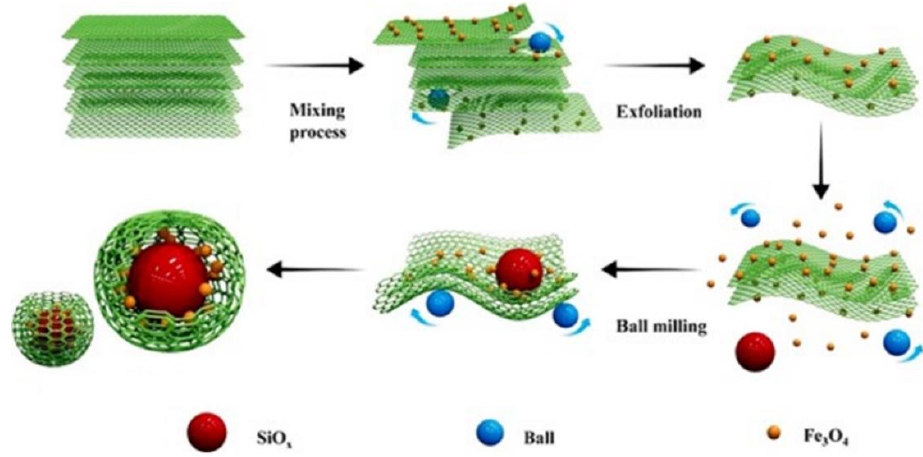
Figure 7. Production scheme of Fe 3 O 4 -pillared onto SiO x microspheres and wrapped by graphene. Reproduced, adapted and reprinted with permission from Reference [94] .